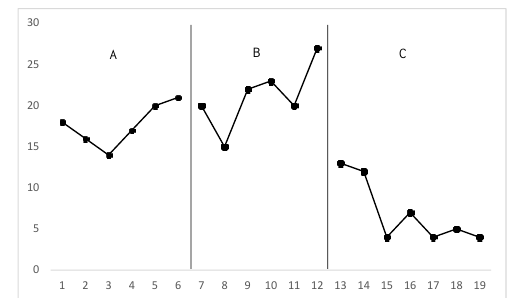
Figure 1. Visual Display of Class Data Collected Using an ABC Design: Instances of Disruptive